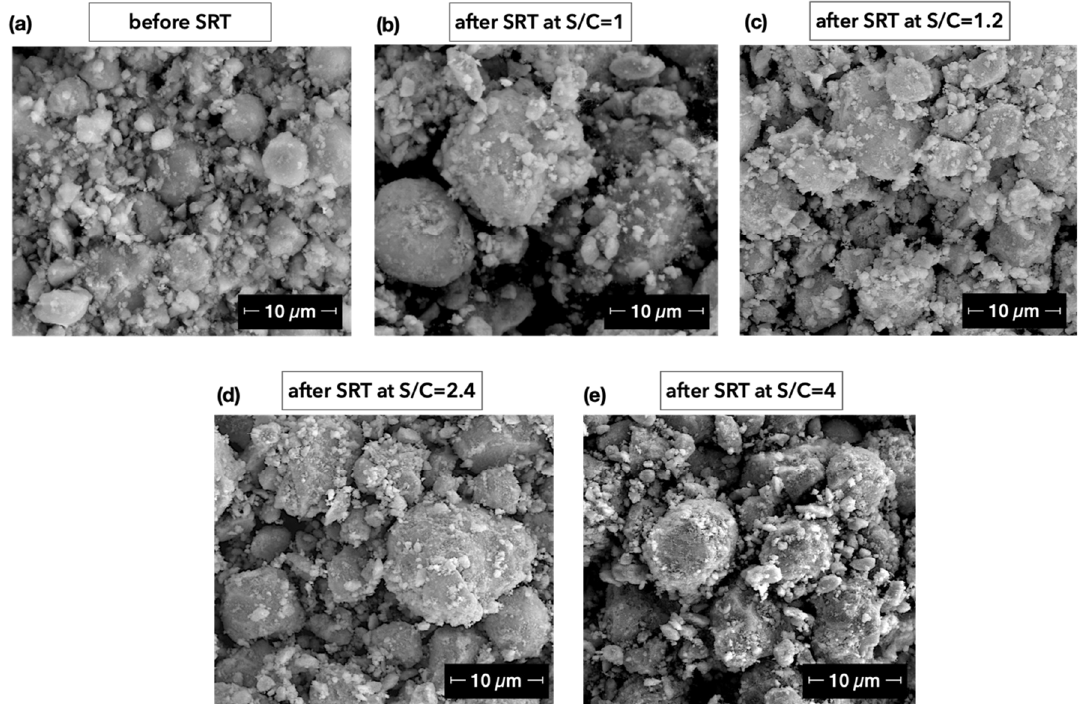
Figure 3. SEM images of Ni/CeZrO 2 before reaction ( a ) and after catalytic tests carried out at S/C = 1 ( b ), S/C = 1.2 ( c ), S/C = 2.4 ( d ) and S/C = 4 ( e ). ( b ), S/C = 1.2 ( c ), S/C = 2.4 ( d ) and S/C = 4 ( e